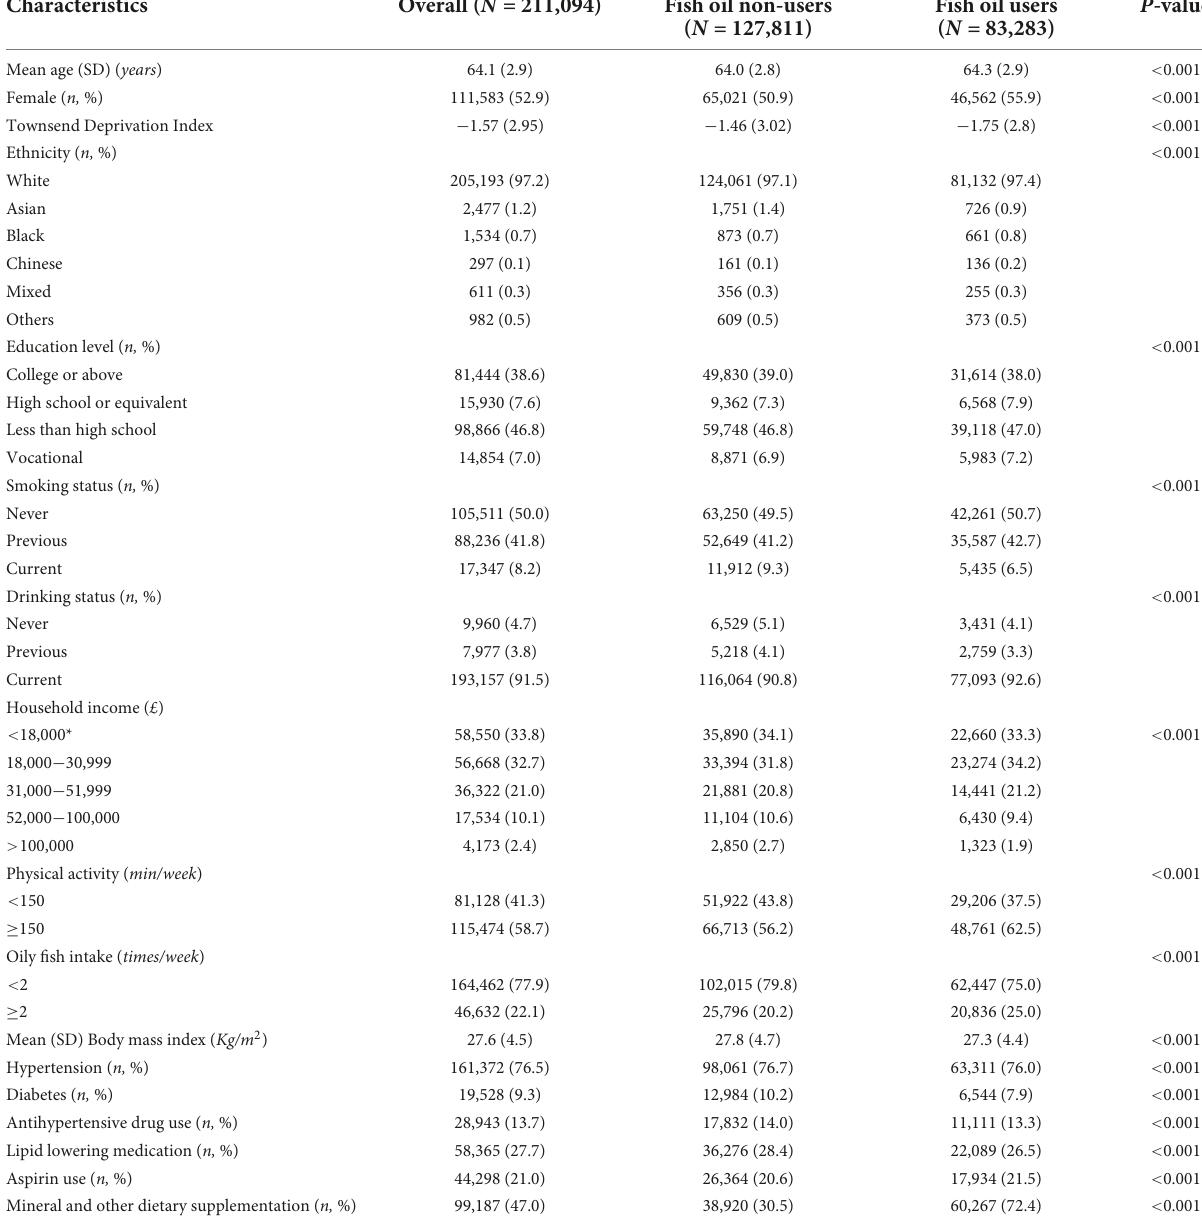
TABLE 1 Baseline characteristics of the study participants stratified by fish oil use.